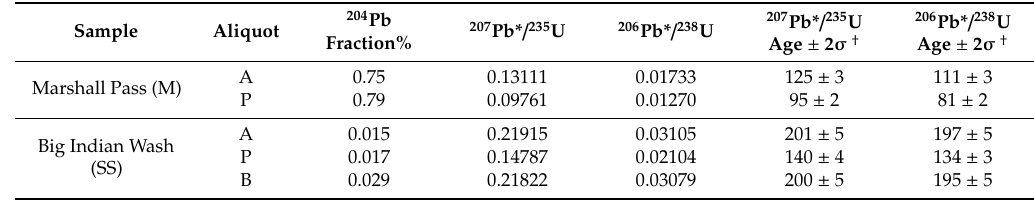
Table 3. 204 Pb fraction and calculated 207 Pb* / 235 U and 207 Pb* / 235 U ratios and corresponding ages for each uraninite sample aliquot (pristine, altered, and